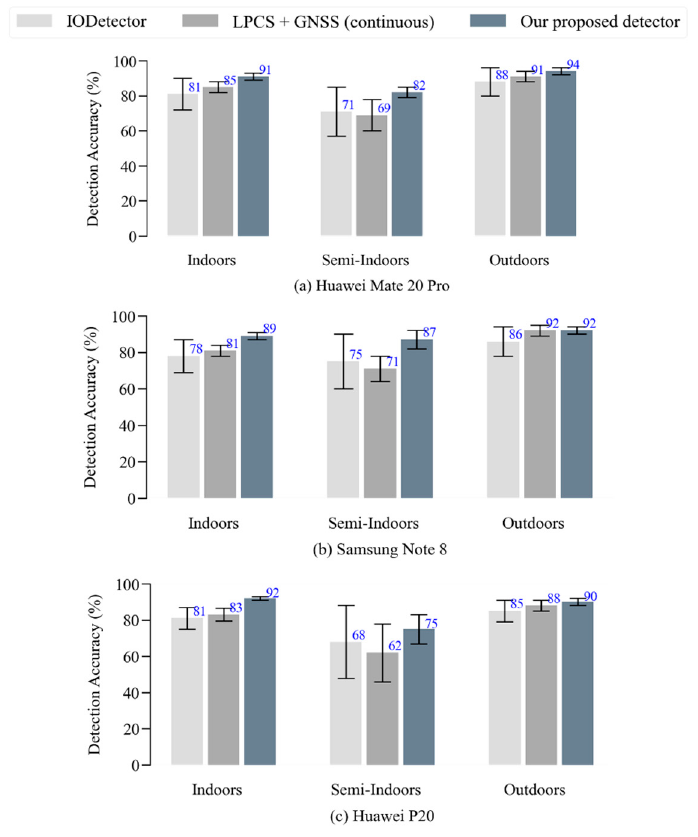
Figure 9. I/O detection accuracy using different detection approaches and smartphone models in indoor, semi-indoor, and outdoor